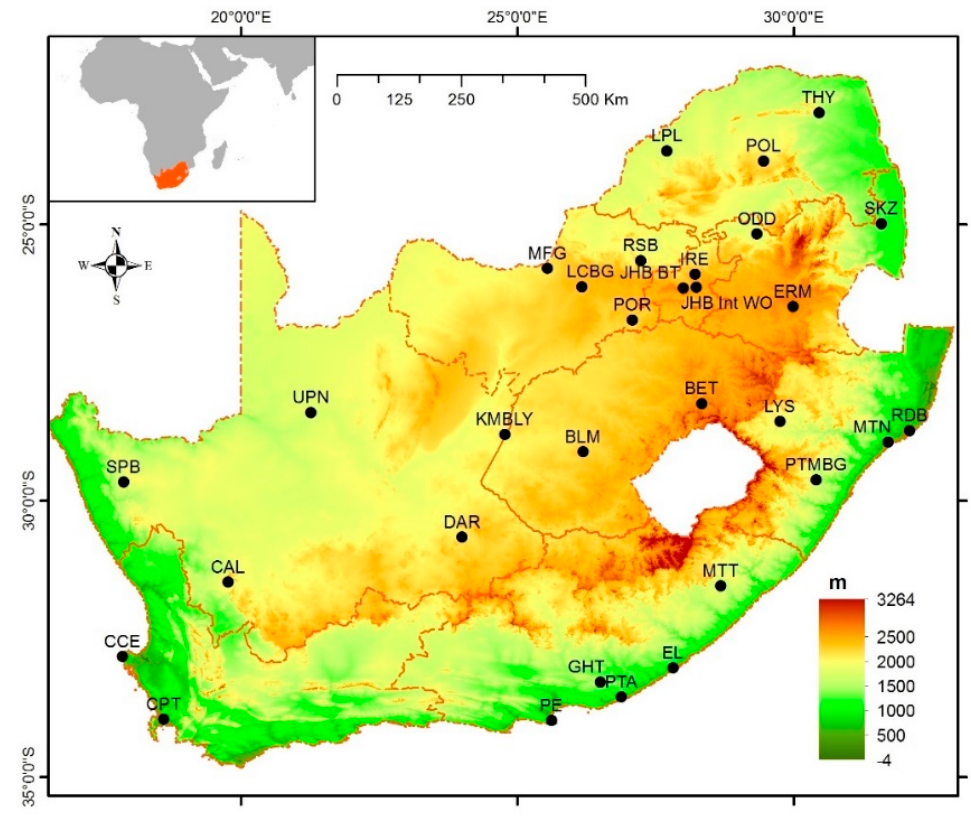
Figure 1. Location of South Africa, along with the distribution of the meteorological stations.